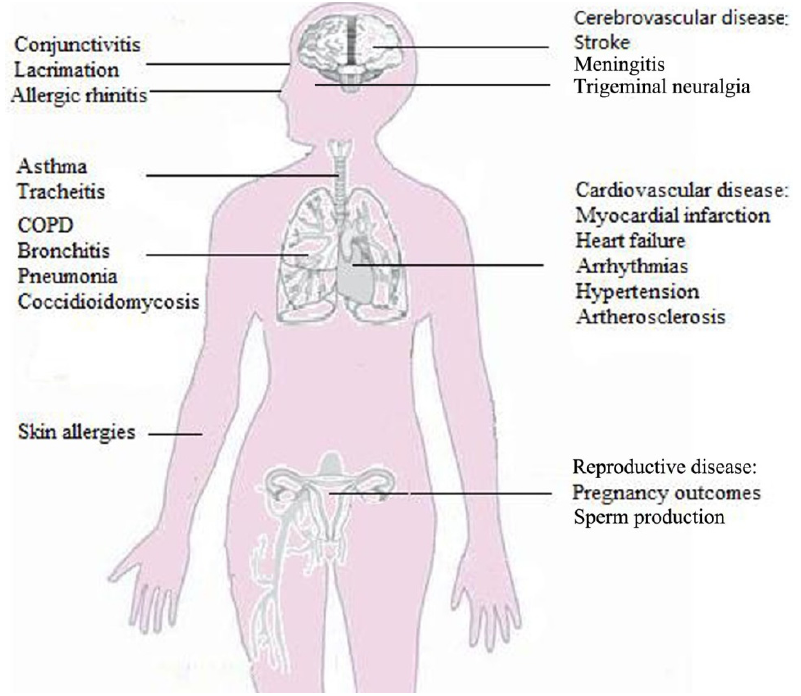
Figure 3. Schematic drawing of desert dust-related human diseases in different organs.